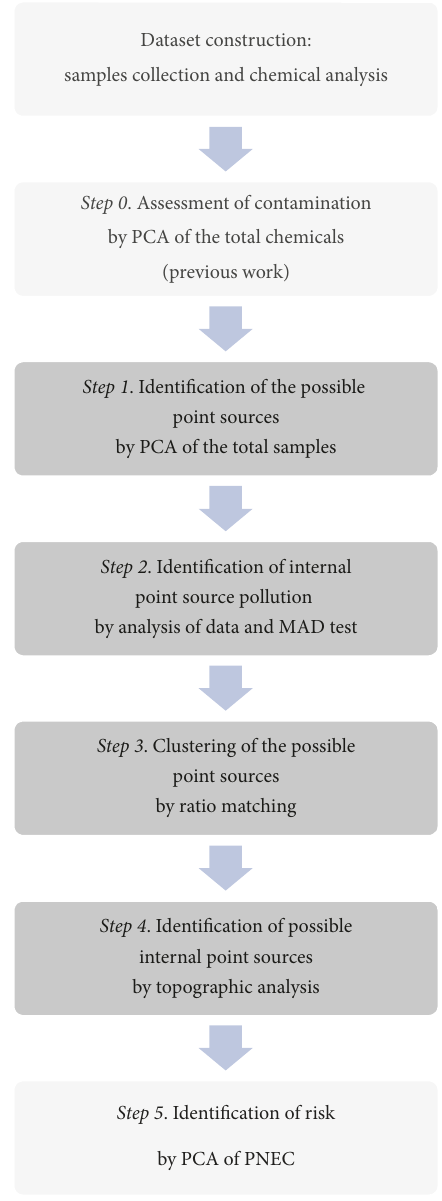
Figure 4: Flow chart of the proposed